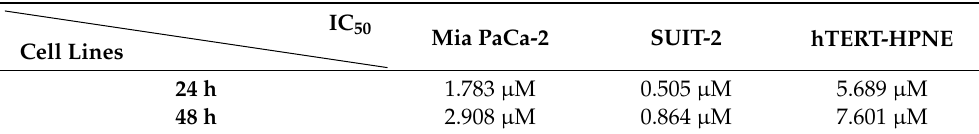
Table 1. The 50% inhibitory concentration (IC 50 ) values of pancreatic ductal adenocarcinoma (PDAC) cell lines (Mia PaCa-2 and SUIT-2) and normal pancreas cell lines (hTERT-HPNE) under betulinic acid (BA) treatment for 24 and 48